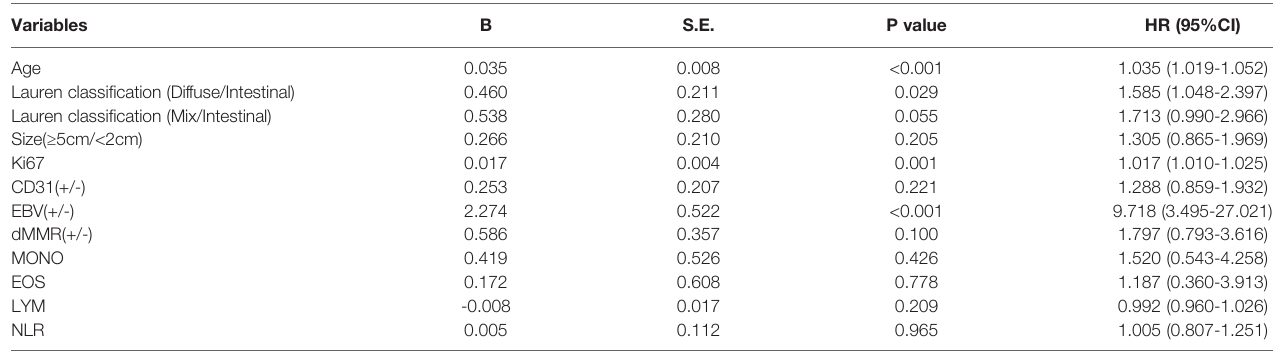
TABLE 6 | The Multivariate Logistic Regression Analyses of the PD-L1 expression of CPS ≥ 10. Variables